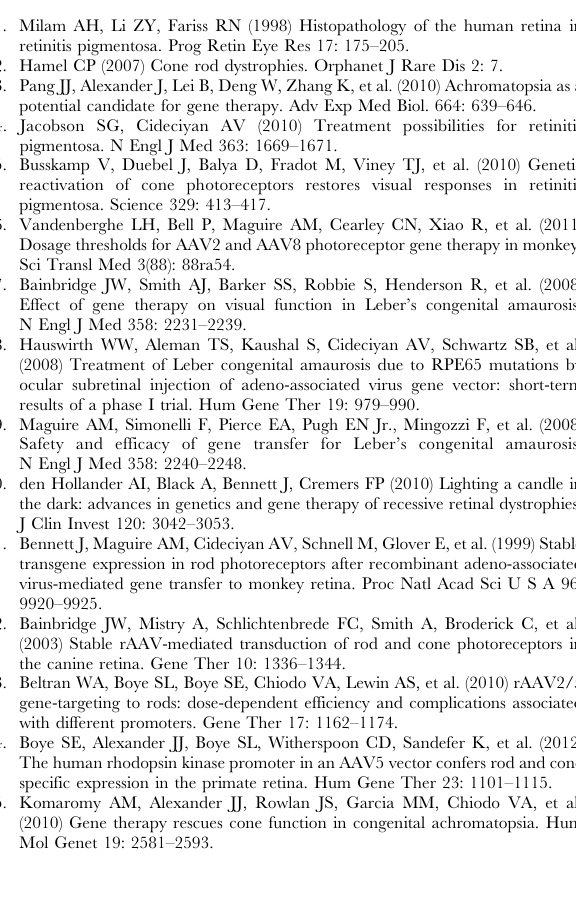
Figure S1 Topology sampling for cone tropism